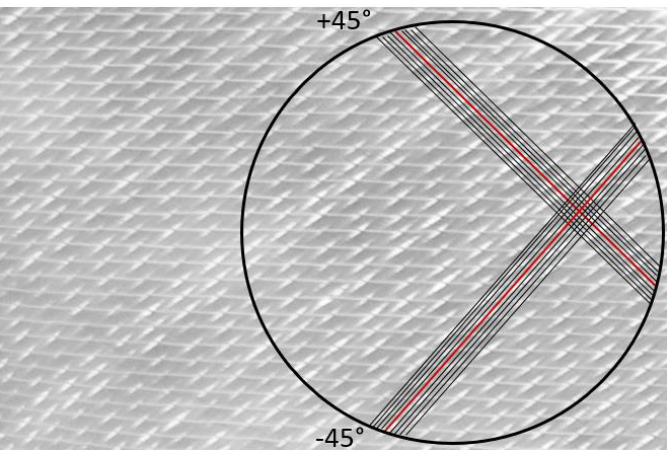
Figure 2. Glass non-crimp fabric 220 g/m² (biaxial, silane) fabric.